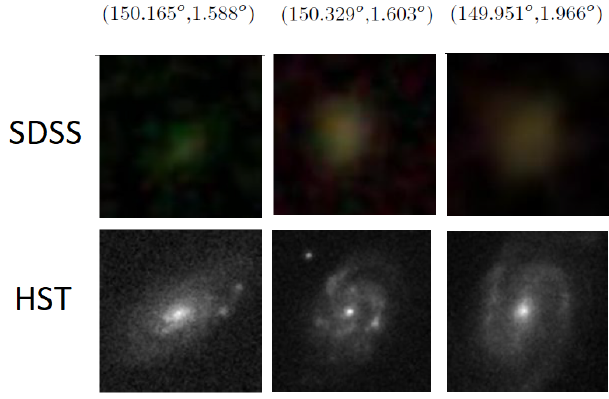
Figure 10. Examples of galaxies imaged by both HST and SDSS, while in images acquired by SDSS the galaxies do not seem to have an identifiable spin direction, the HST images of the exact same galaxies show that these galaxies have counterclockwise spin patterns. The equatorial celestial coordinates of each galaxy are specified at the top of each